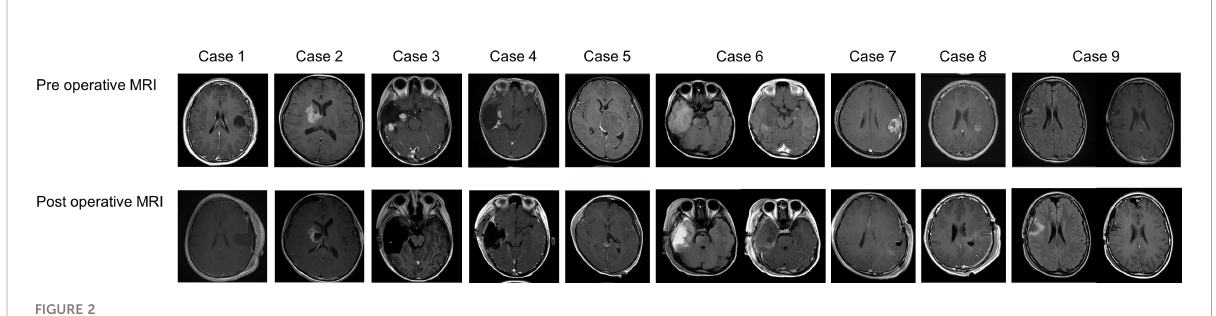
FIGURE 2 Magnetic resonance imaging fi ndings for all enrolled cases.